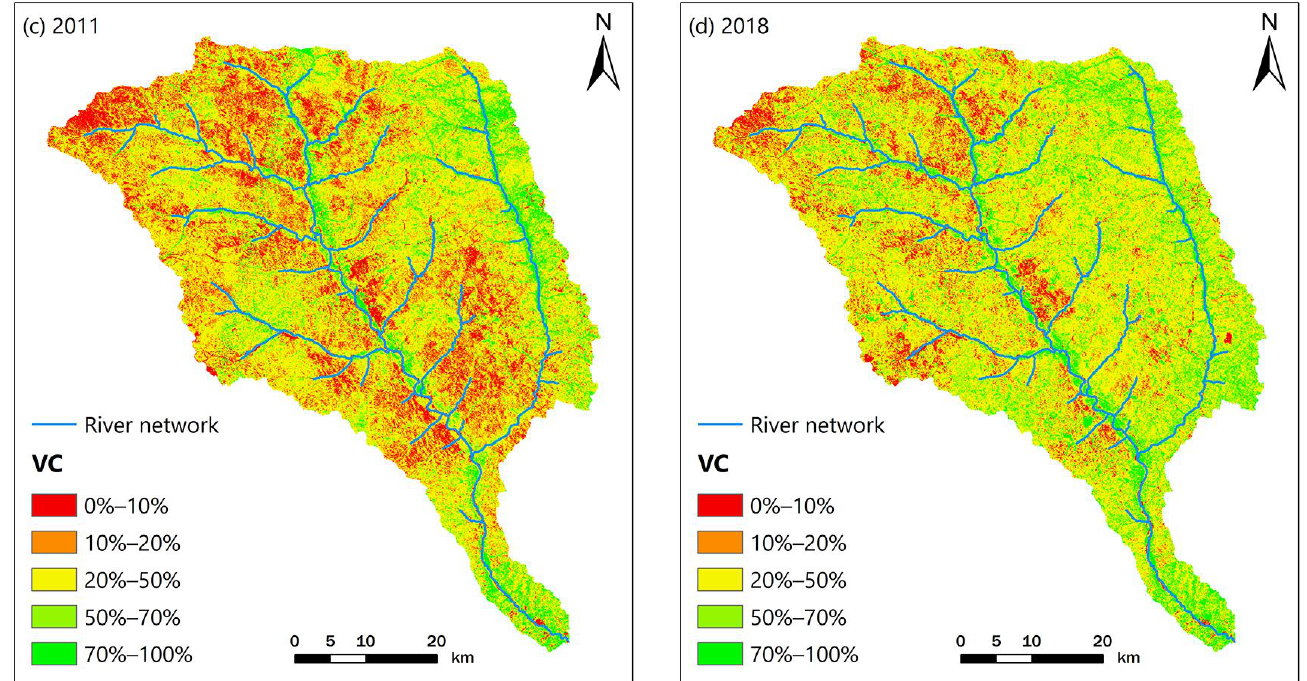
Figure 6. Vegetation cover ( VC ) changes in the Huangfuchuan watershed. ( a ) VC map in 1990. ( b ) VC map in 2000. ( c ) VC map in 2011. ( d ) VC map in 2018.